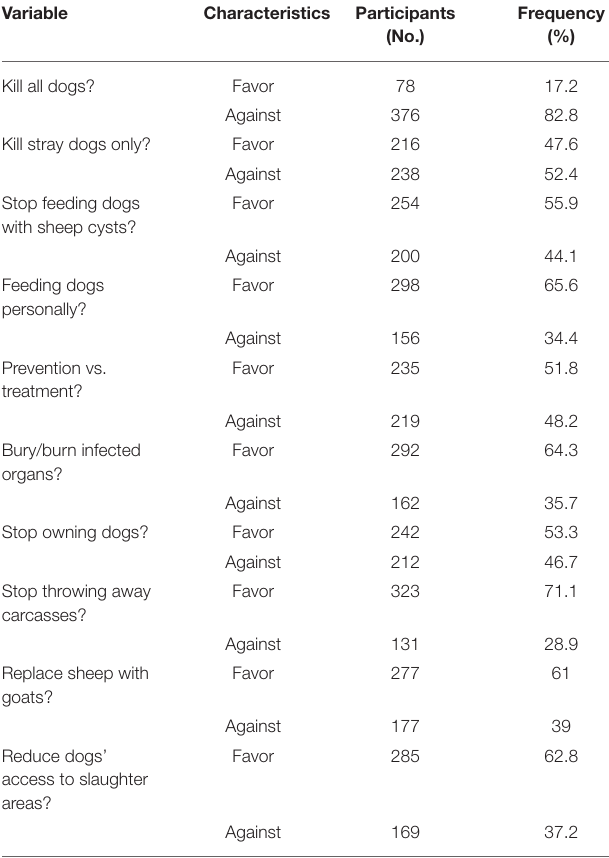
TABLE 4 | Representation of Risk factors of CE across different variables. Variable